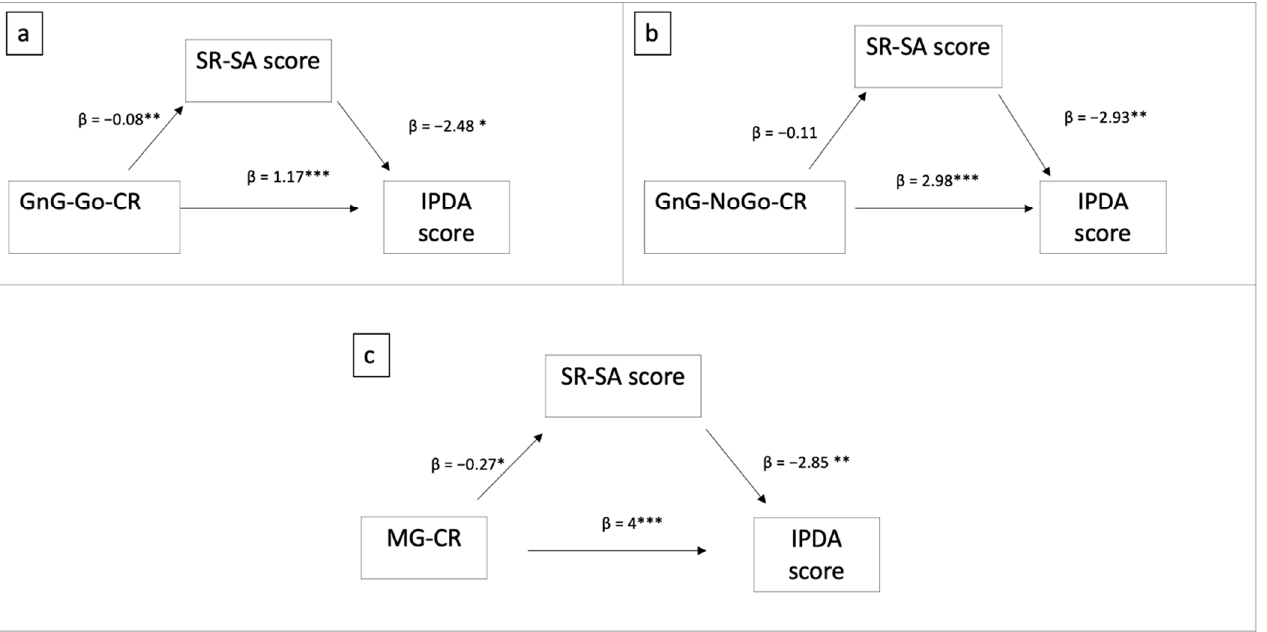
Figure 4. Direct and indirect effect of the EFs (( a ): correct responses at Go-NoGo Test Go condition; ( b ): correct responses at Go-NoGo Test NoGo condition; ( c ): correct responses at Mr. Giraffe test) on the IPDA score via the Self-regulation behavior during structured activities scores. * p < 0.05; ** p < 0.01; *** p < 0.001.